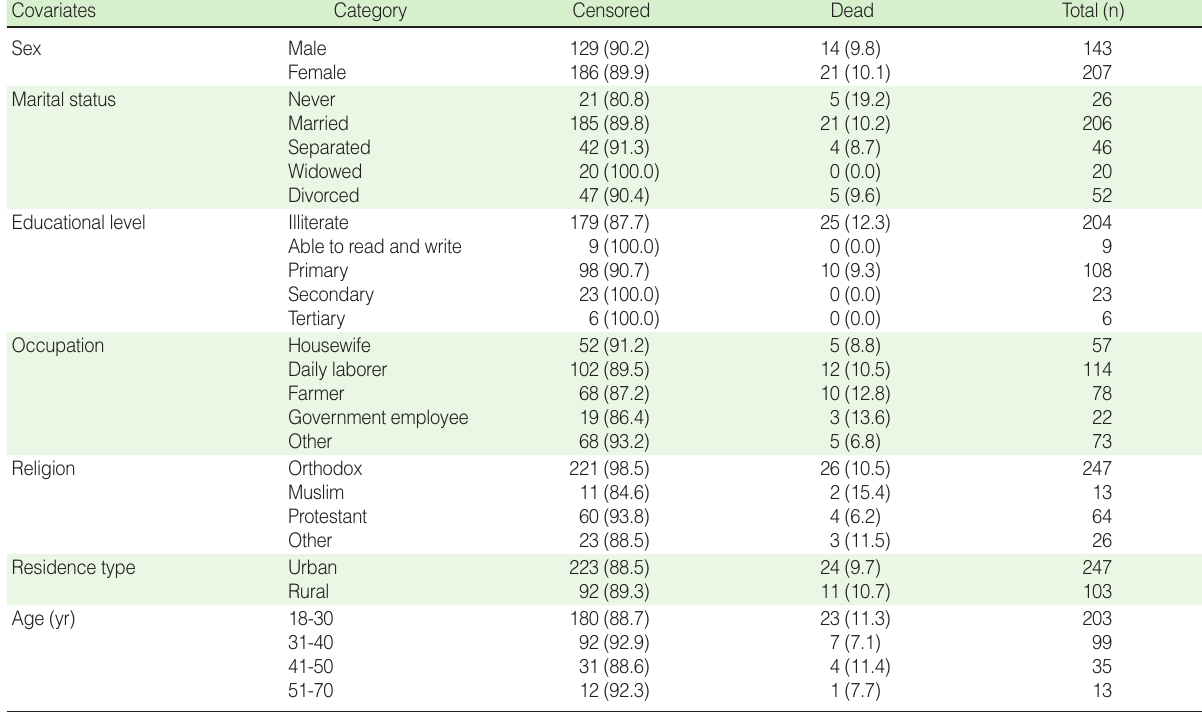
Table 1. Socio-demographic characteristics of HIV patients receiving ART at Jinka Zonal Hospital, Jinka, South Omo, Ethiopia in 2016